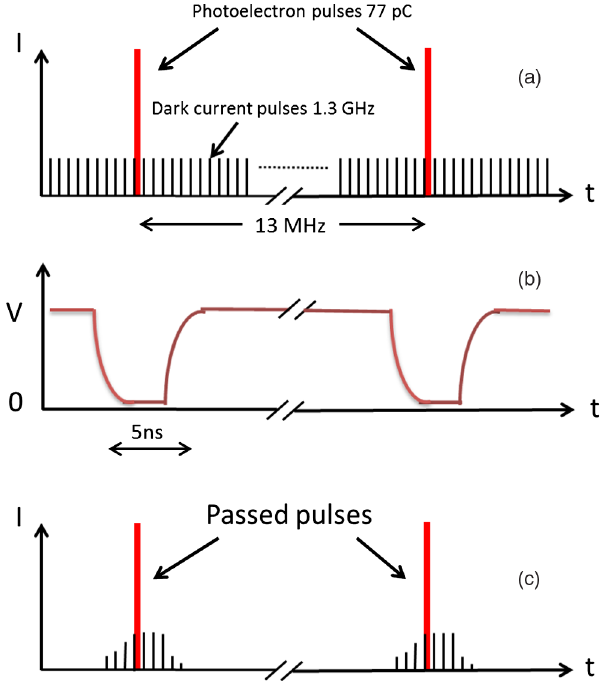
FIG. 12. The basic concept of the kicker designed for the SRF gun [19].